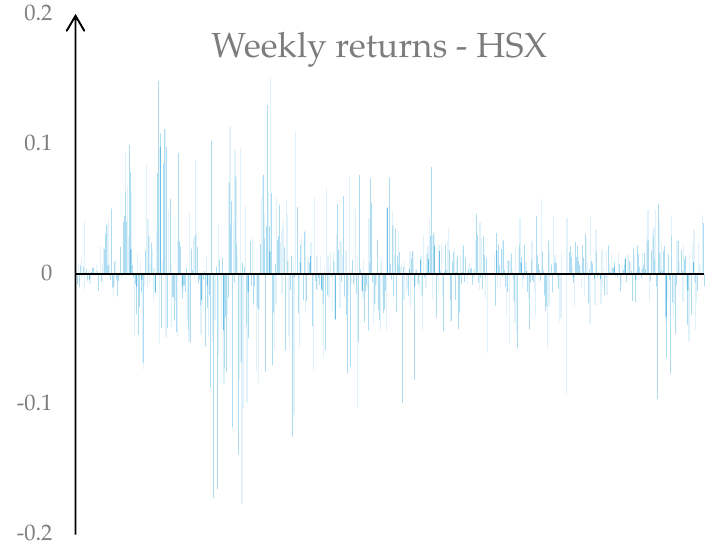
Figure 1. The weekly returns of HSX in the period from 2005 to 2019.